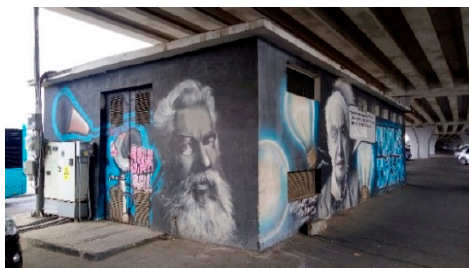
Figure 33. Under Pipera Bridge, Bucharest by Mihai Com ă nescu (Boeme), 2013 (photo taken in 2020).